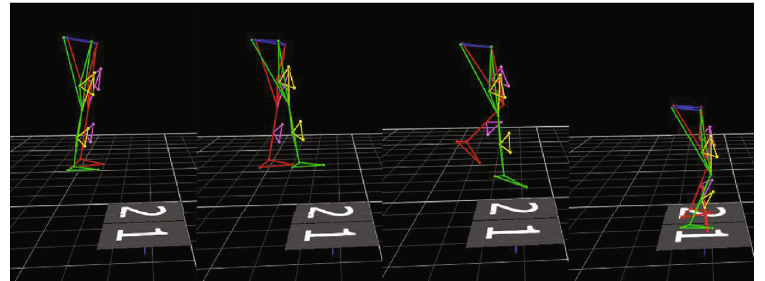
Figure 3: Schematic diagrams of landing mode.